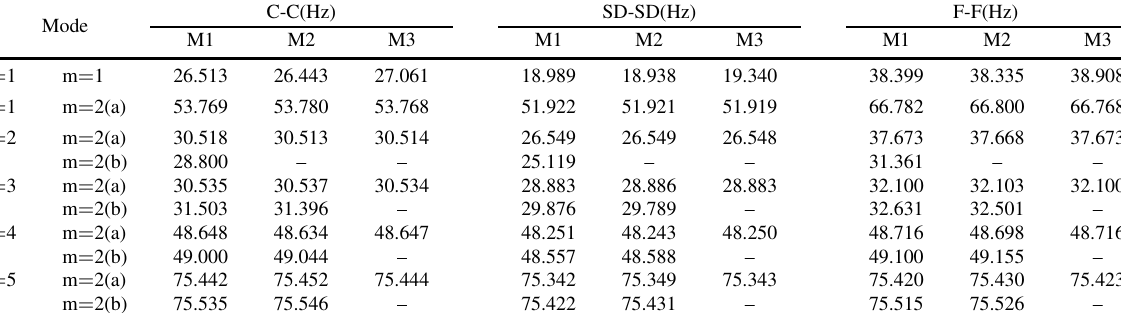
Table 6 Comparison of natural frequencies of model M1, M2 and